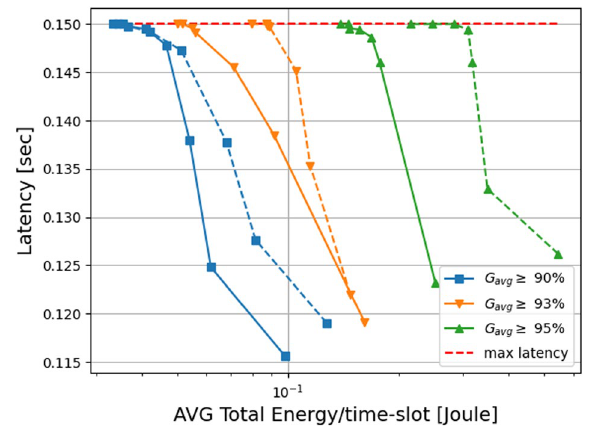
Fig. 4 Total energy/latency trade-off for ensemble learning (solid) and deep-CE only (dashed). This figure makes a comparison of the trade-offs between the energy consumption of the overall system (UE obtained with a compression system which encompasses only the deep-CE and a compression system composed of all the considered compression strategies (ensemble)